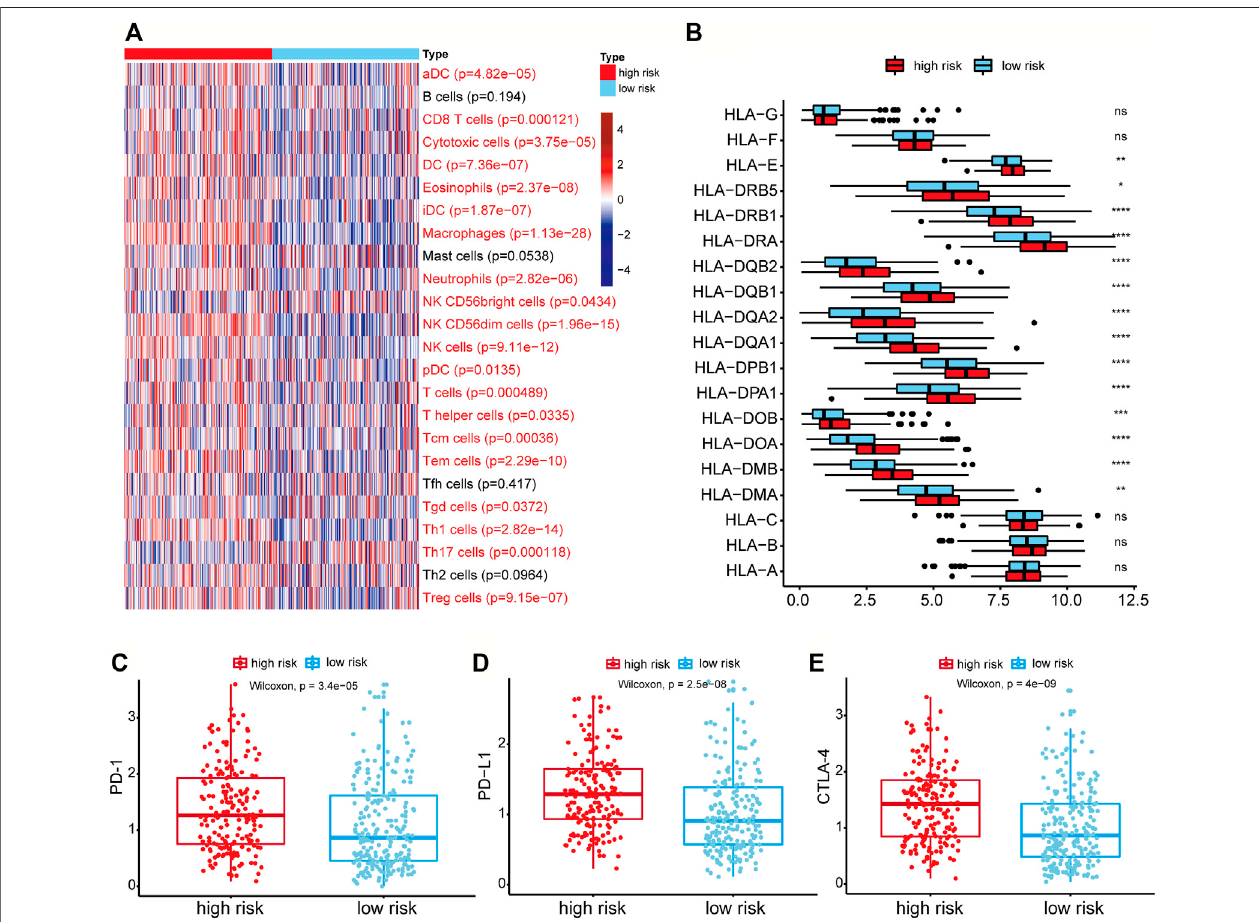
FIGURE 6 | Differential immune-related cells and genes between the high-risk group and low-risk group. (A) Heatmap ofthe activities of 24 immune cells between high-risk and low-risk groups analyzed by ssGSEA. The p -value was calculated by the Wilcoxon rank-sum test. Immune cells with red labels referred to p < 0.05. (B) The expressionofHLA-relatedgenesbetweenhigh-riskandlow-riskgroups.ns: p > 0.05,* p < 0.05,** p < 0.01,*** p < 0.001,**** p < 0.0001. (C – E) GenesexpressionofthePD-1, PD-L1, CTLA4 in the high-risk and low-risk